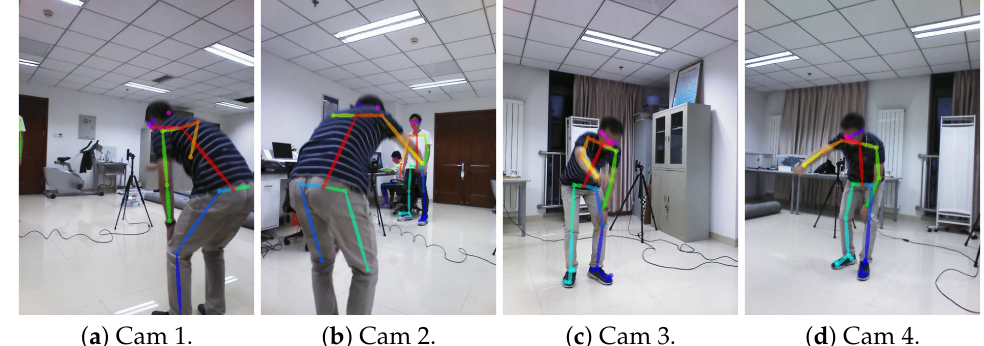
Figure 7. The OpenPose detection results of four camera views with body25 definitions.